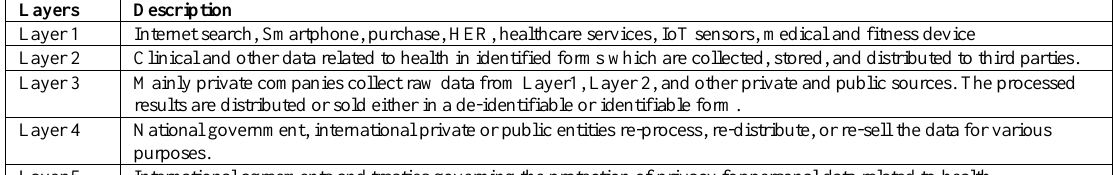
Table 2. Datafication layers of personal health data